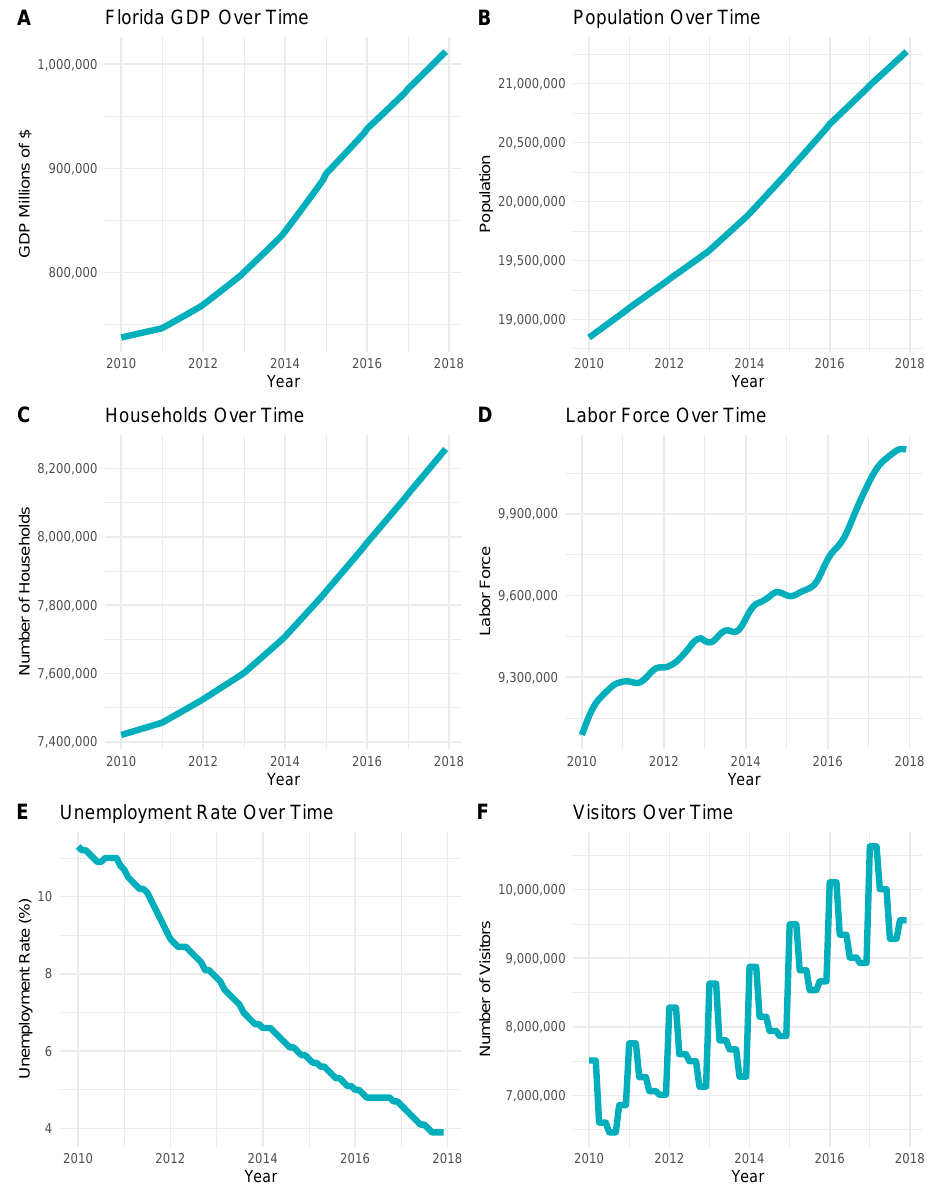
Figure 3. Social economic variables over